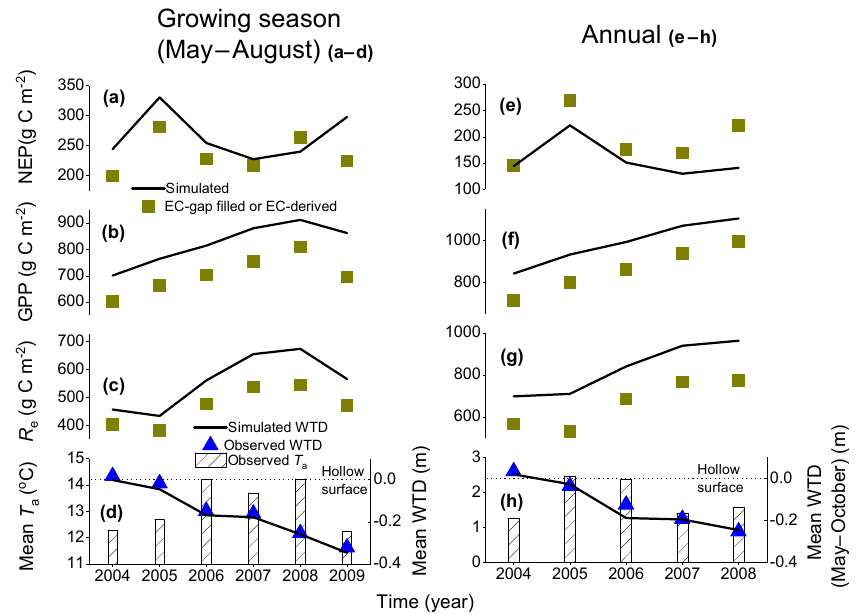
Figure 7. Modeled and EC-derived (Flanagan and Syed, 2011) growing season (May–August) sums of (a) NEP, (b) GPP and (c) R e during 2004–2009; (d) observed mean growing season T a and measured and modeled average growing season WTD during 2004–2009; modeled and EC-derived (Flanagan and Syed, 2011) annual sums of (e) NEP, (f) GPP and (g) R e during 2004–2008 and (h) observed mean annual T a and measured and modeled average WTD during ice-free periods (May–October) of 2004-2008 at a western Canadian fen peatland. A negative WTD represents a depth below hollow surface, and a positive WTD represents a depth above hollow surface. A positive NEP means that the ecosystem is a carbon sink. Annual modeled vs. EC gap-filled NEP, GPP and R e estimates for 2009 were not compared due to the lack of flux measurements from September to December in that